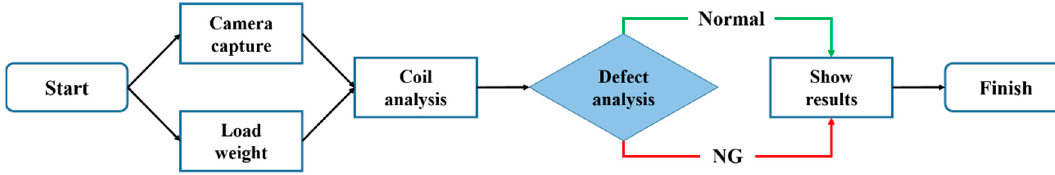
Figure 3. Diagram of the coil defect detection system.